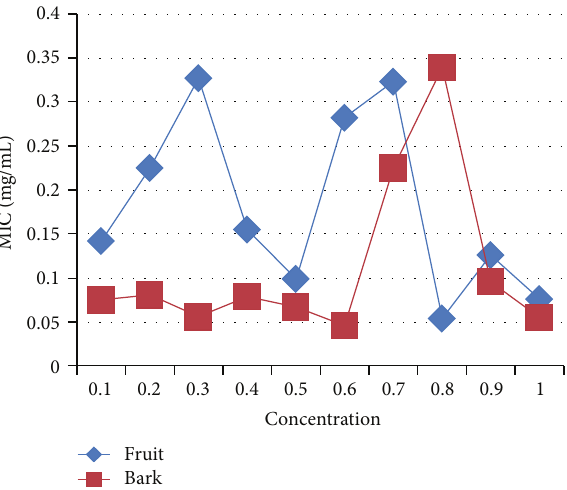
Figure 14: MIC values (mg/mL) exhibiting potential of the bark and fruit of C. ambrosioides against A. niger .